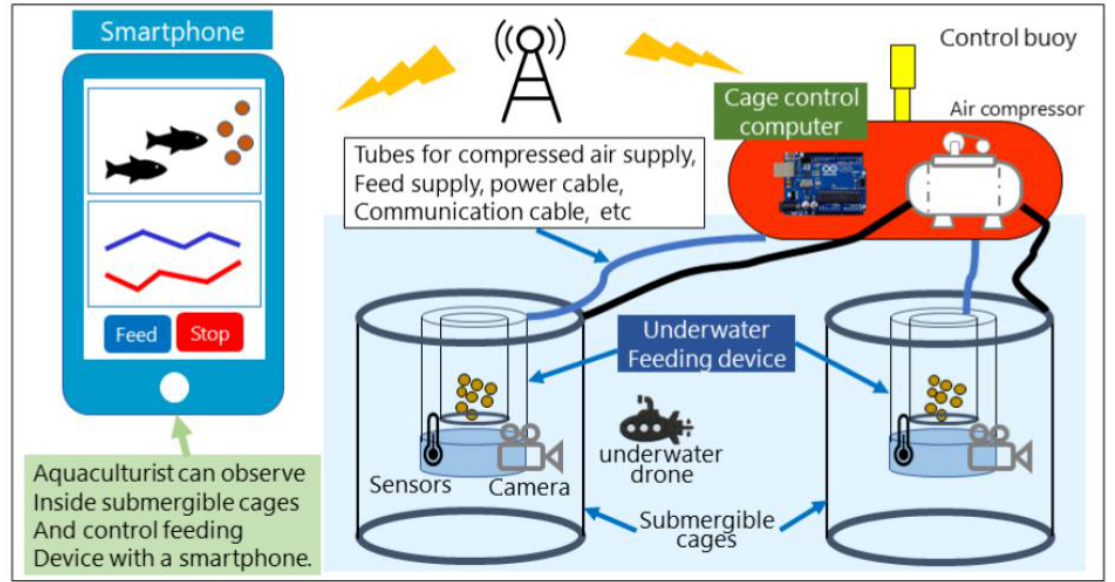
Figure 13. A theoretical smart aquaculture system [105].